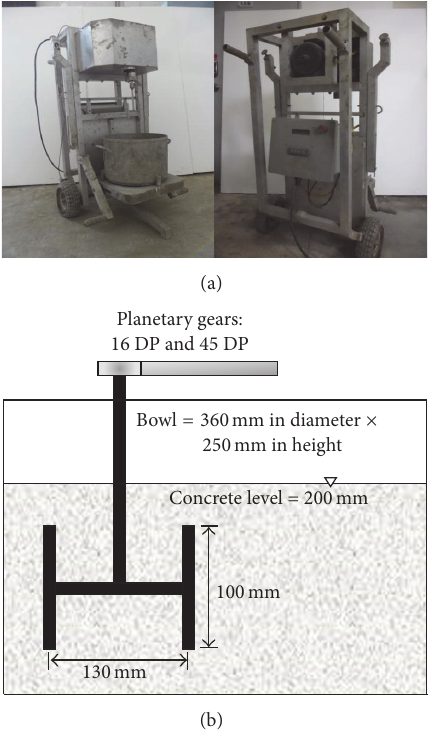
Figure 1: IBB rheometer: (a) front and rear view and (b) schematic diagram.